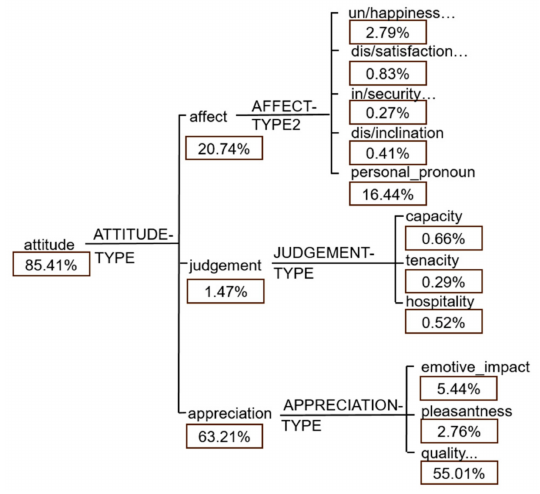
Figure 1. Use of attitude resources in the